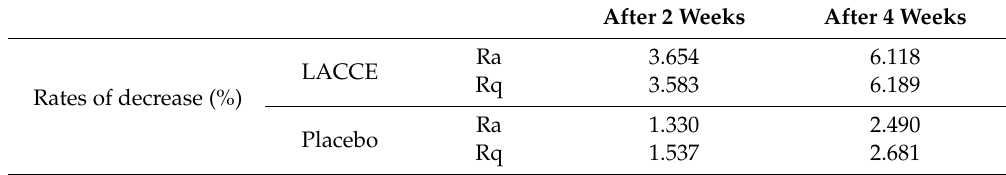
Table 2. Rates of decrease of roughness parameters of periorbital wrinkles